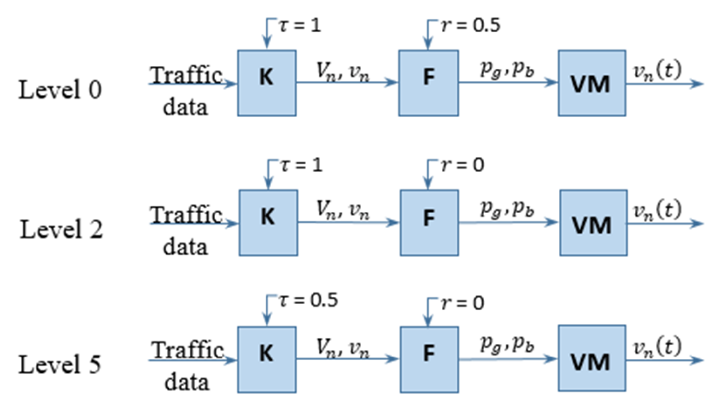
Figure 4. Driver model with different degree of automation.